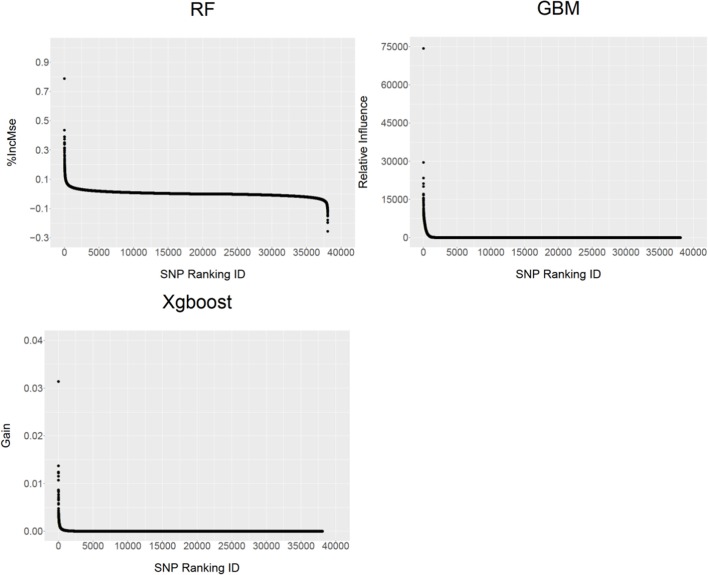
The distribution profiles of ranked SNP variable importance (VIM) values from RF (%IncMSE), GBM (Relative Influence) and XgBoost (Gain).